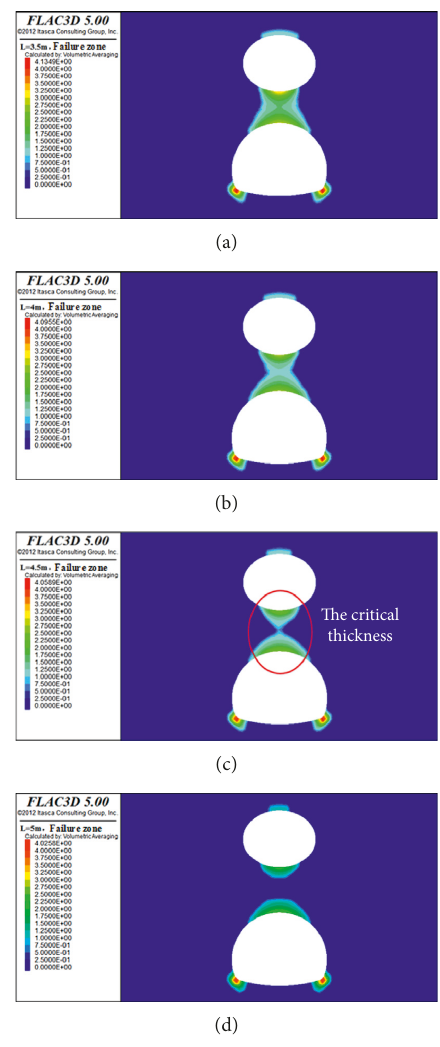
Figure 13: Failure zone scope in the water-resistant strata obtained by the user-defined program on FLAC 3D . (a) The water-resistant thickness of 3.5 m. (b) The water-resistant thickness of 4.0 m. (c) The water-resistant thickness of 4.5m. (d) The water-resistant thickness of 5.0